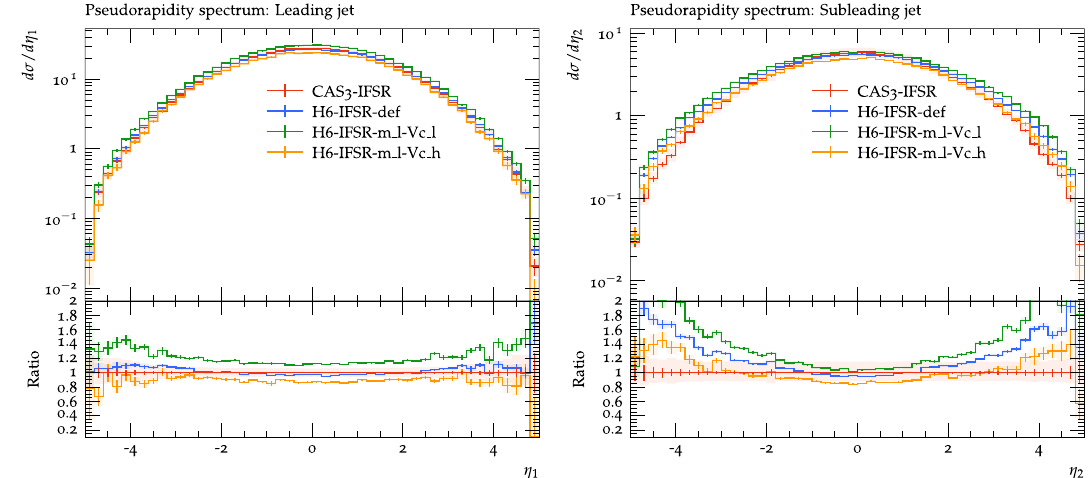
Fig. 11 ComparisonofpredictionsobtainedwithMCatNLO+CAS3andMCatNLO+H6forZ + jetobtainedwithMCatNLO.Shownarepredictions using initial and final state parton shower. The band of MCatNLO+CAS3 shows the uncertainties obtained from scale variation (as described in the